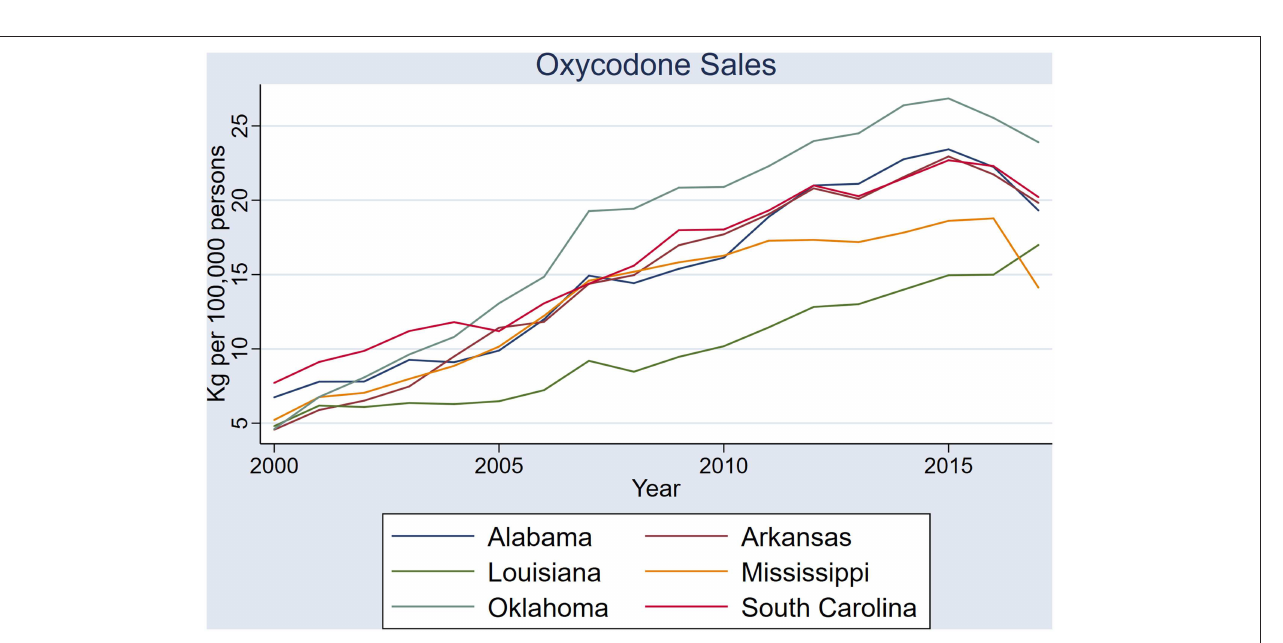
sales each very closely precede same-directional fluctuations in medical-cause mortality by ∼ 1 year ( Figure 8 ). After 2nd differencing both datasets (to achieve time series stationarity, and control for trend), and adjusting the medical- mortality datasets 1 year back (to control for temporality), population hydrocodone exposure was correlated with female